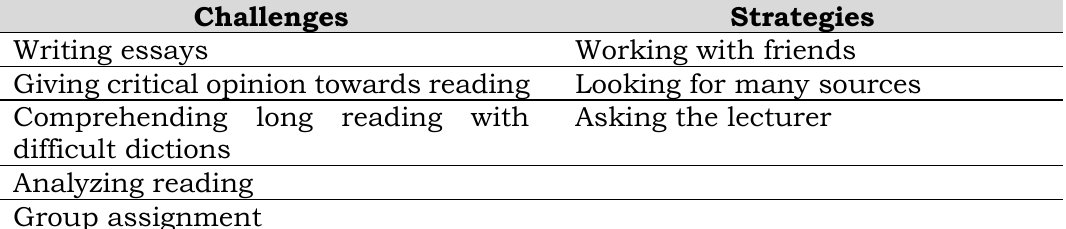
Table 3. Challenges and strategies in critical thinking